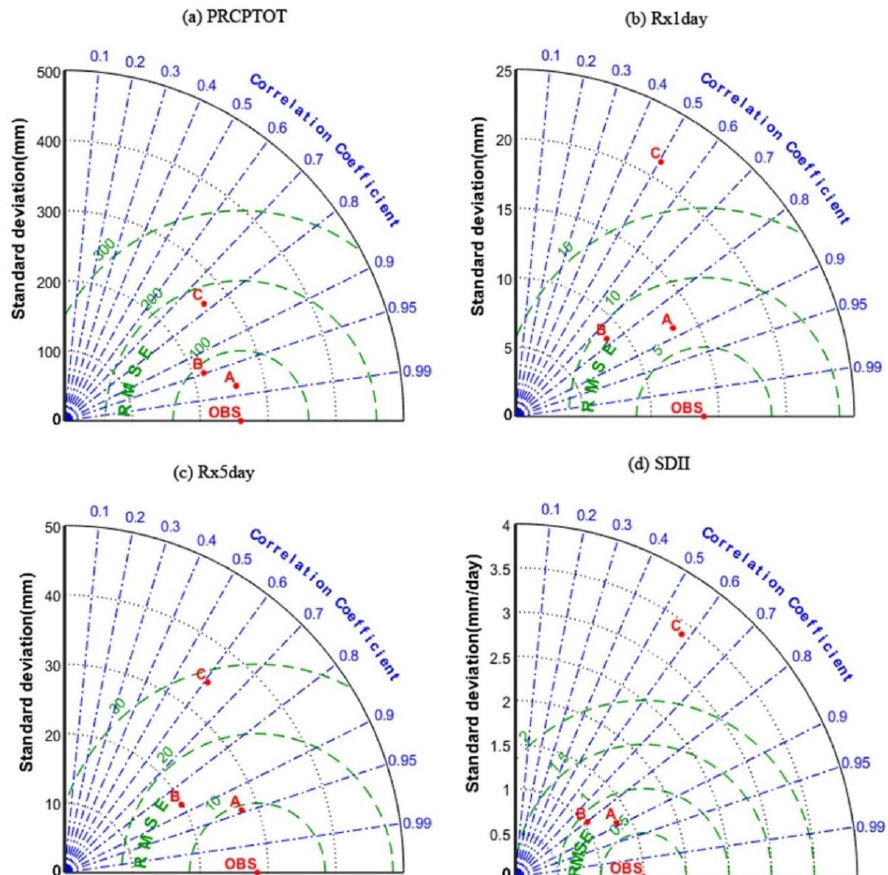
Figure 15. Taylor diagrams indicating correlation coefficients, standard deviation, and RMSE of PRCPTOT, Rx1day, Rx5day, and SDII indices from 1981 to 2014. ( A ) CMFD, ( B ) APHRODITE, and ( C ) CHIRPS. The radial coordinate (y axis) represents the magnitude of standard deviation, concentric semicircles represent RMSE, and the angular coordinate represents the correlation coefficient.